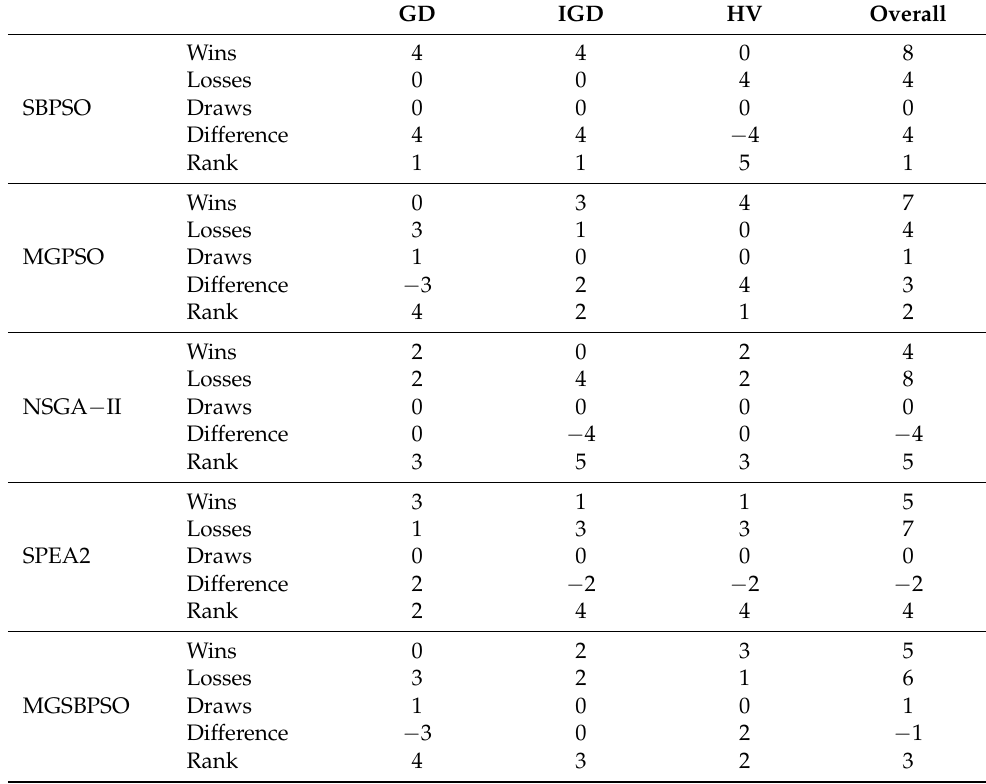
Table 12. S&P 100 rankings for each performance